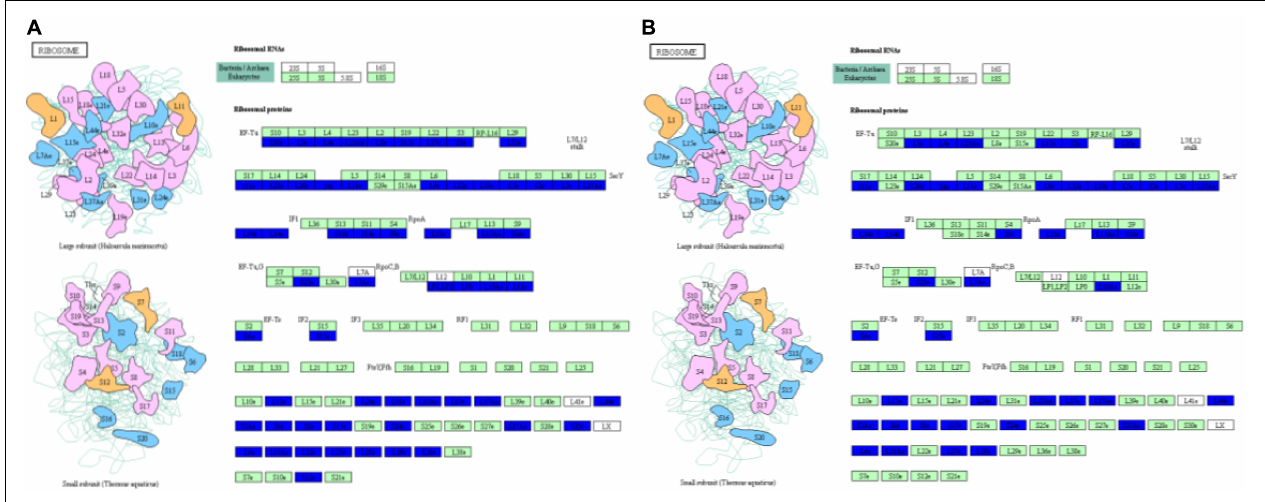
FIGURE 3 | Changes in protein conformation and large and small ribosomal subunits structural under p-stress. (A) P1 vs. P31; (B) P11 vs. P31. TABLE 2 | The nodules number, volume and changes compared to P31. Treatments Nodules number Nodules